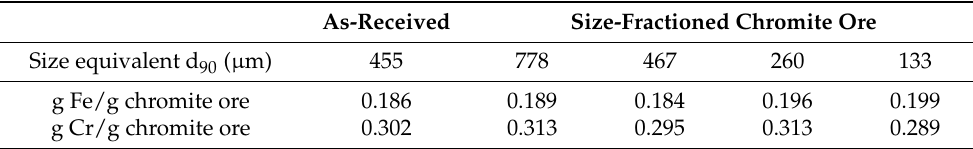
Table 2. Total amount of Fe and Cr present per in the as-received chromite and the size-fractioned chromite ores.